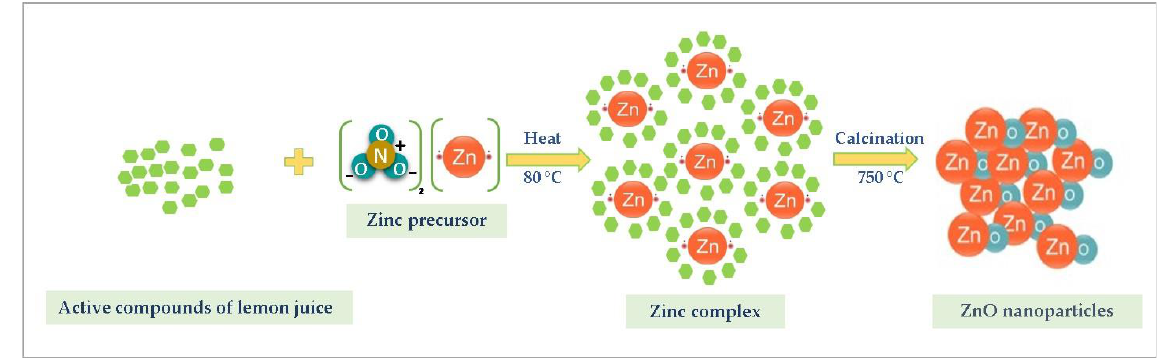
Figure 2. Mechanism of the formation of ZnO nanoparticles.